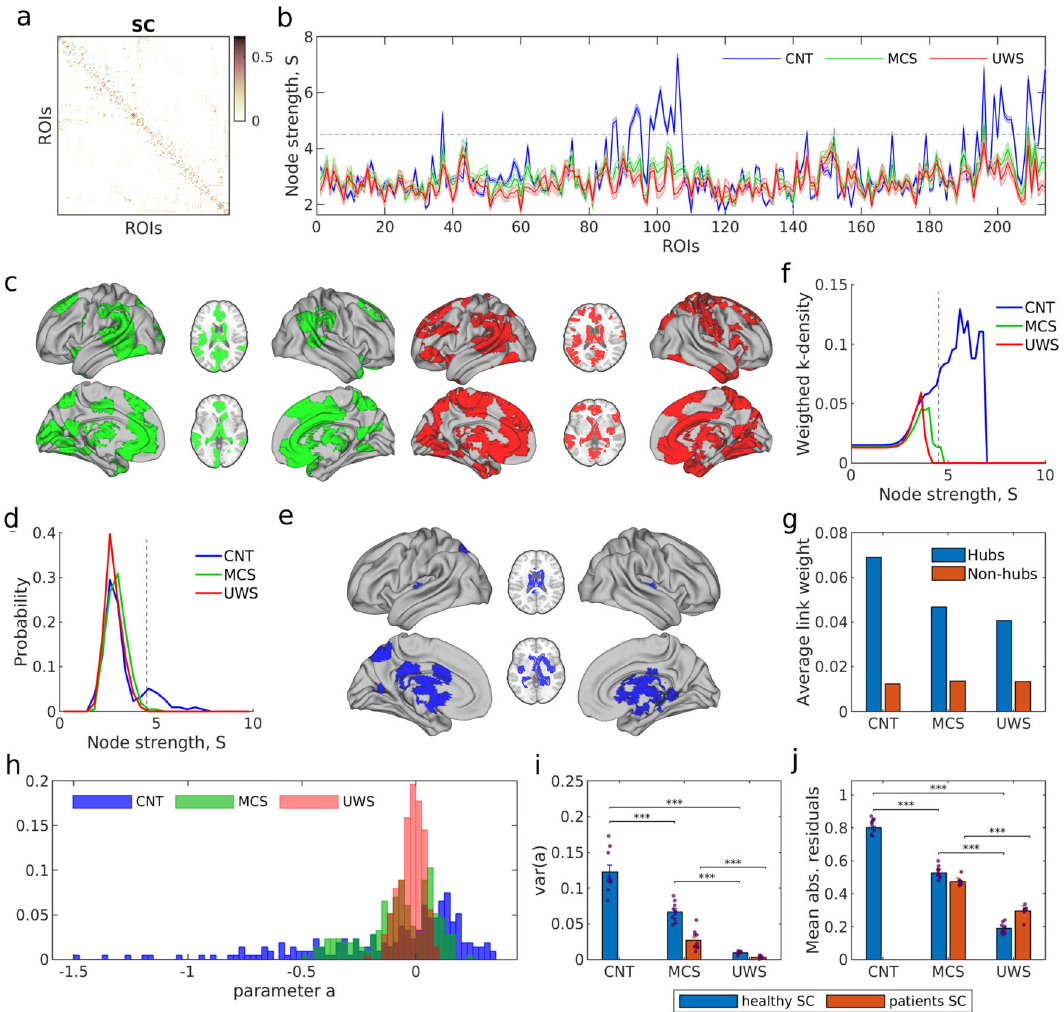
Fig. 6 Disruption of the structural connectivity in DOC patients. a SC matrices were averaged over subjects for each clinical group (CNT, MCS, and UWS). b Average node strength of each node for each group. Shaded areas represent the standard error across subjects. The grey dashed line corresponds to the threshold, S = 4.5, which determines the hub regions. c ROIs with signi fi cant decrease of strength in patients as compared to controls (Wilcoxon rank-sum test, followed by FDR correction). Left (green): CNT-MCS comparison; Right (red): CNT-UWS comparison. d Distribution of the node strength in the population average SCs. The distribution in controls displays a longer tail corresponding to hub regions, depicted in e . f k-density curves – average weight of links between regions with strength S > S 0 – show the loss of a rich-club structure in MCS and UWS patients. g Average link weight between hubs (i.e. regions with S > 4.5) in yellow and the average link weight between non-hubs regions (i.e. S < 4.5) in violet. h Distribution of the estimated bifurcation parameters a j using the average SC for each clinical group (healthy, MCS, and UWS). i The variance of the distribution of parameters a j for each clinical group. j Median of the absolute residuals of the linear relationship between the a eff vs strength. ***: p < 0.001, Wilcoxon rank-sum test, followed by FDR